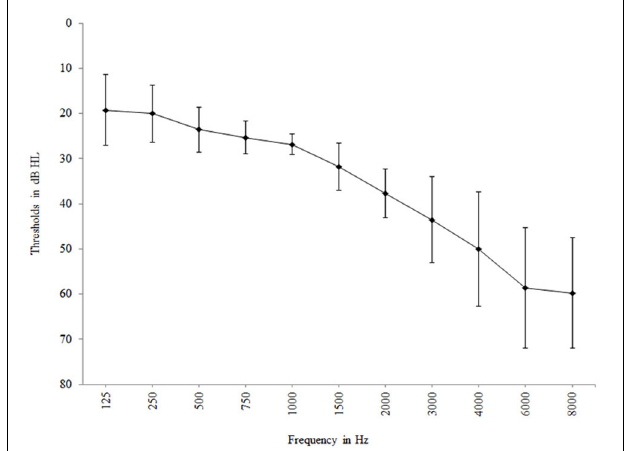
FIGURE 1 | Mean hearing threshold at the 11 measured frequencies. Error bars represent standard deviation.